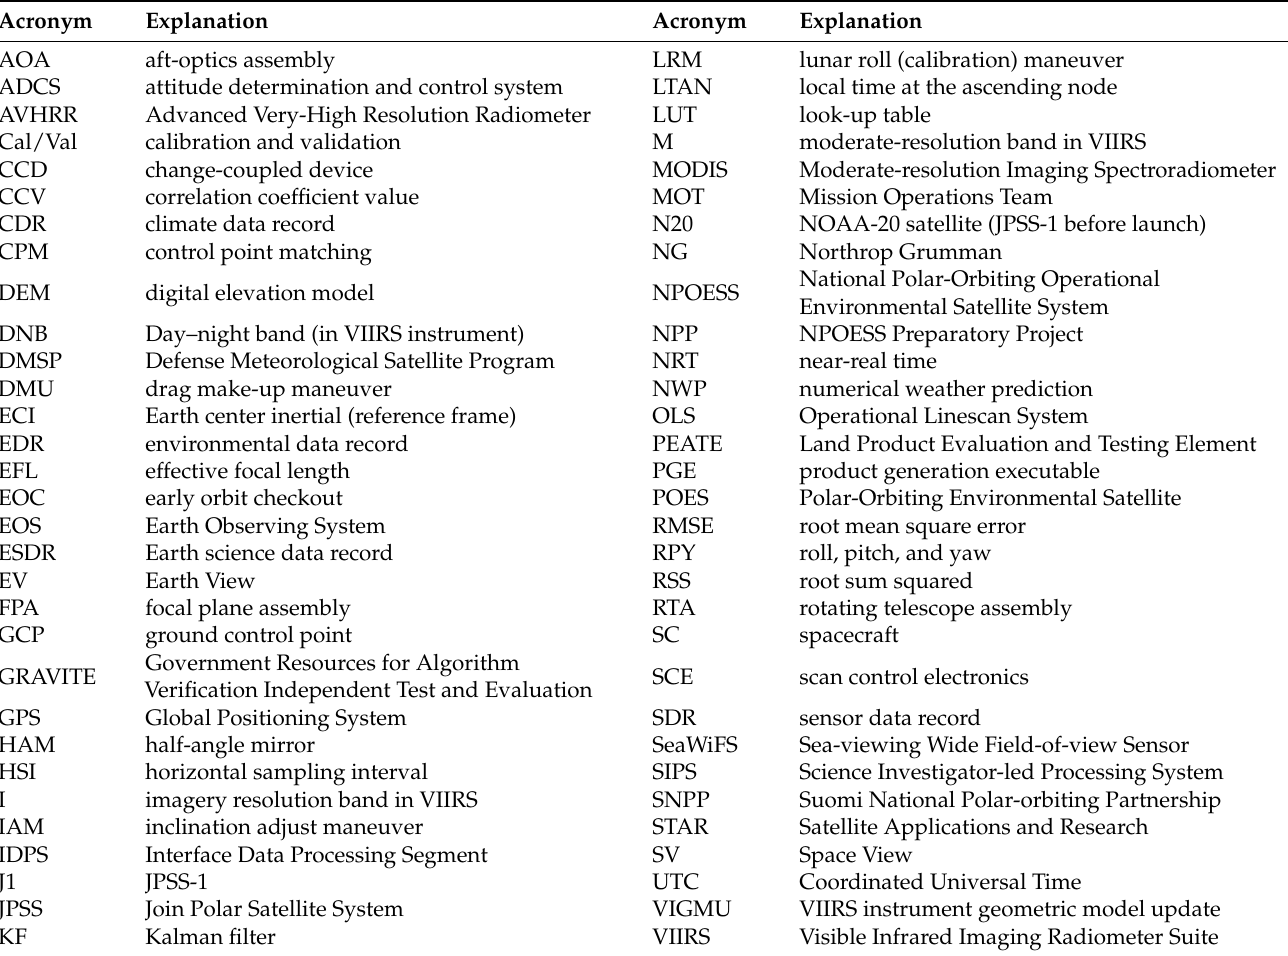
Table A1. Abbreviations used in this